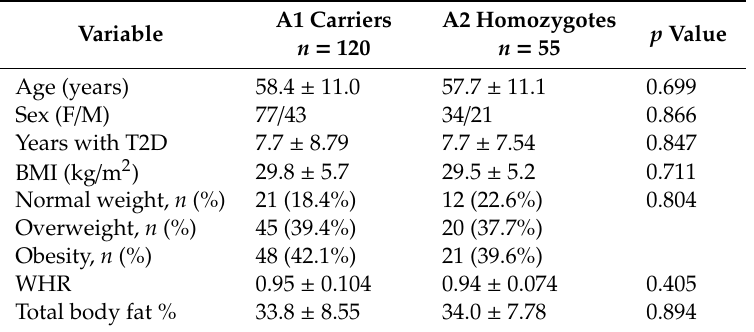
Table 1. Characteristics of the diabetic patients according to genotypes of the DRD2 / ANKK1 TaqIA